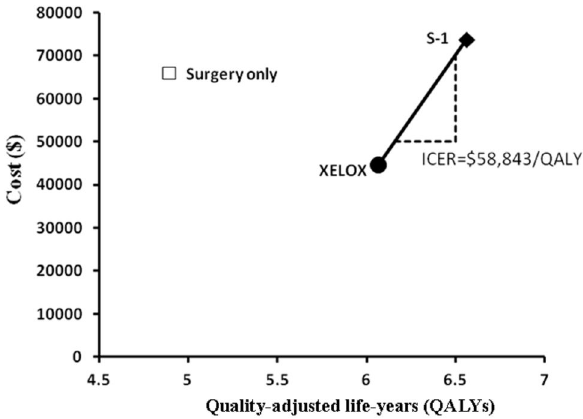
Figure 3. Base-case results on the cost-effectiveness of first-line strategies for resectable gastric cancer patients. The line joining strategies of capecitabine and oxaliplatin (XELOX) and S-1 is the ‘efficiency frontier’. Strategy above the line is dominated. In the cost-effectiveness plane, the value of incremental cost-effectiveness ratios (ICER) is depicted.